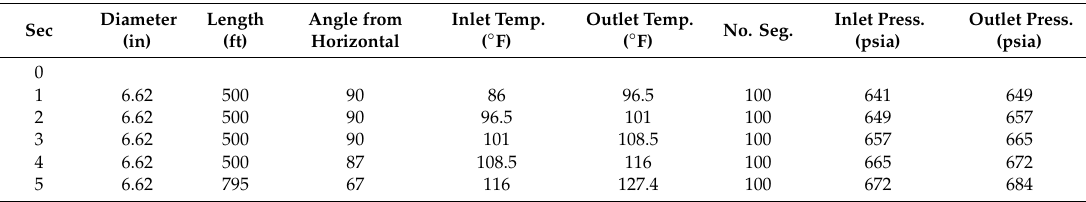
Table 1. Example of the annulus pressure VBA calculation.